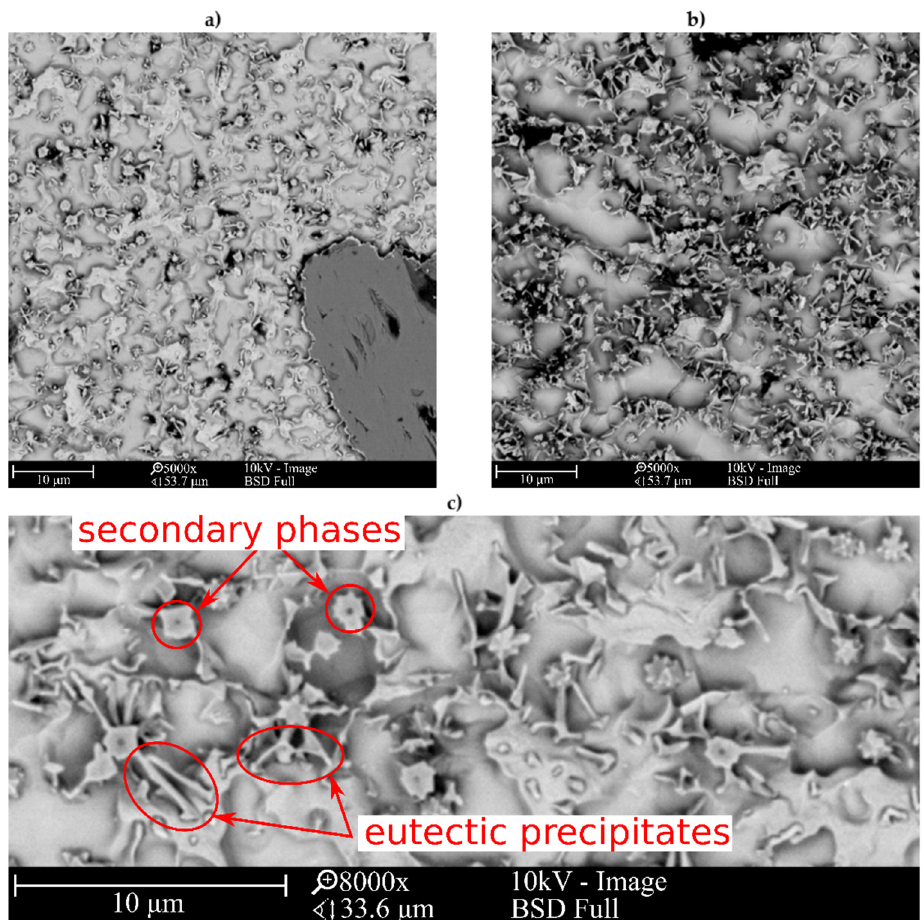
Figure 6. The SEM microstructures of central beads area of laser cladded Inconel 625/TiC coatings; ( a ) M-01 coating, ( b ) M-04 coating, ( c ) M-04 coating (coatings designation according to Table 3).